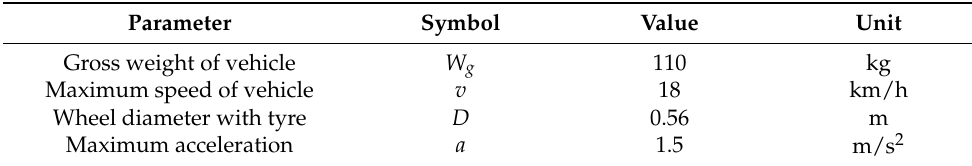
Table 1. Nominal values of simulation parameters.